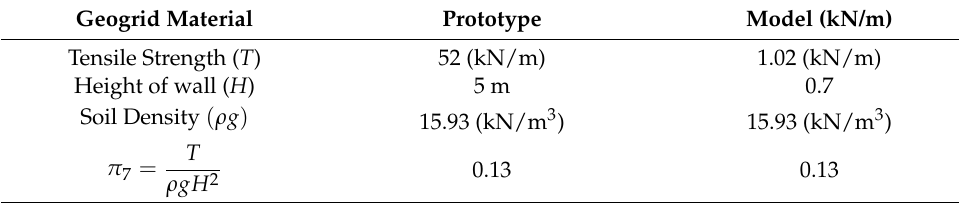
Table 2. Comparision of π 7 factor of a 5 m abutment and